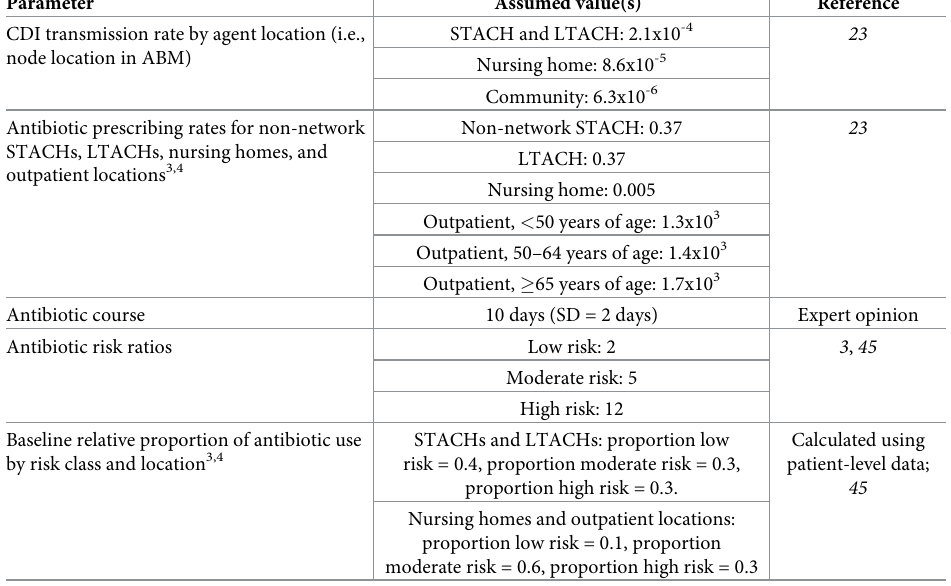
Table 1. Select 1 Clostridioides difficile disease state and antibiotic parameter values.